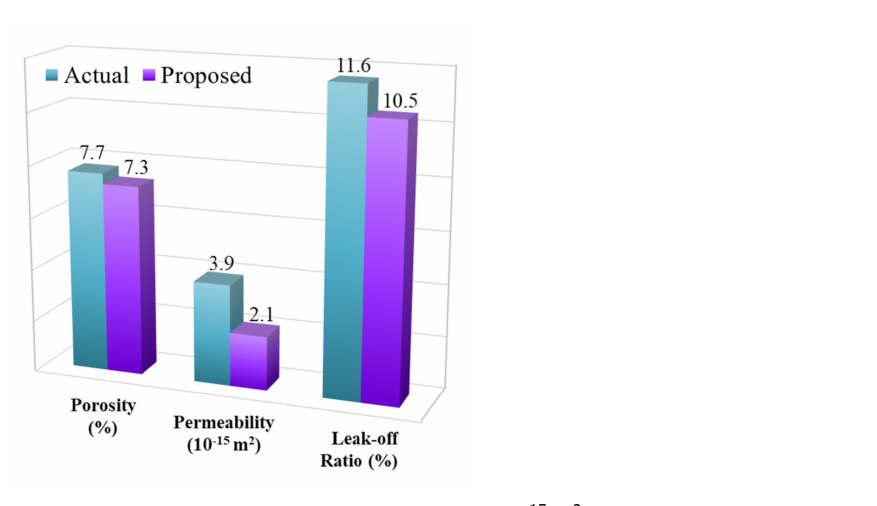
Figure 8. Average porosity (%) and permeability (10 − 15 m 2 ) of actual and proposed models and their leak-off ratio (%)